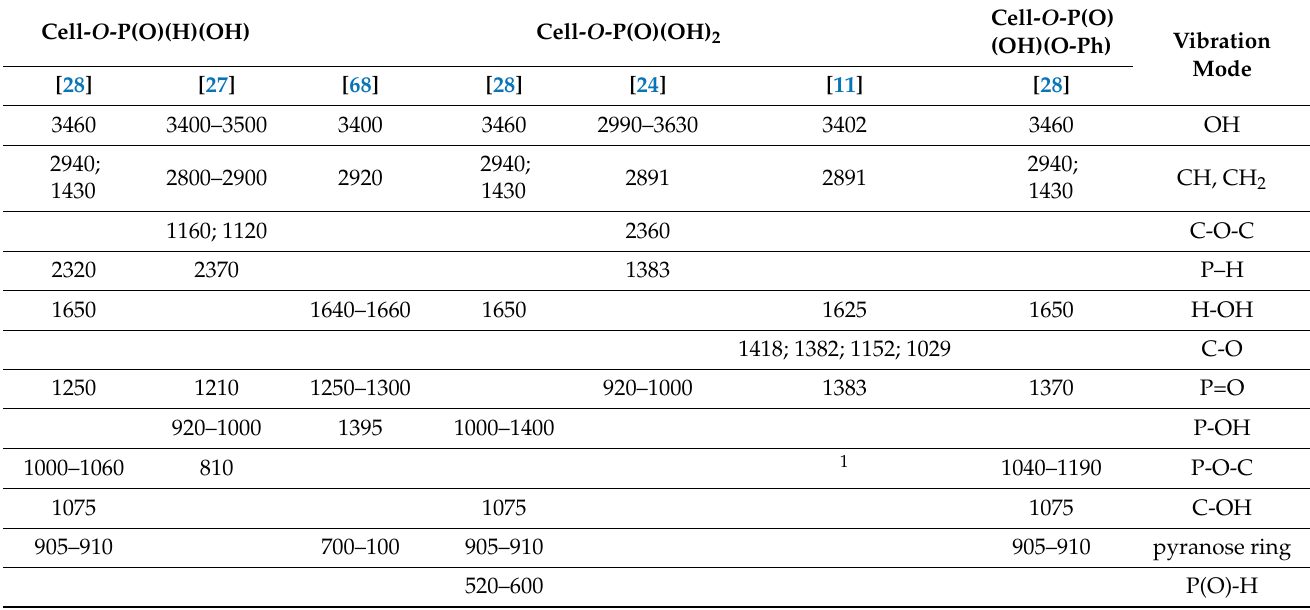
Table 5. IR of cellulose- O -phosphates.